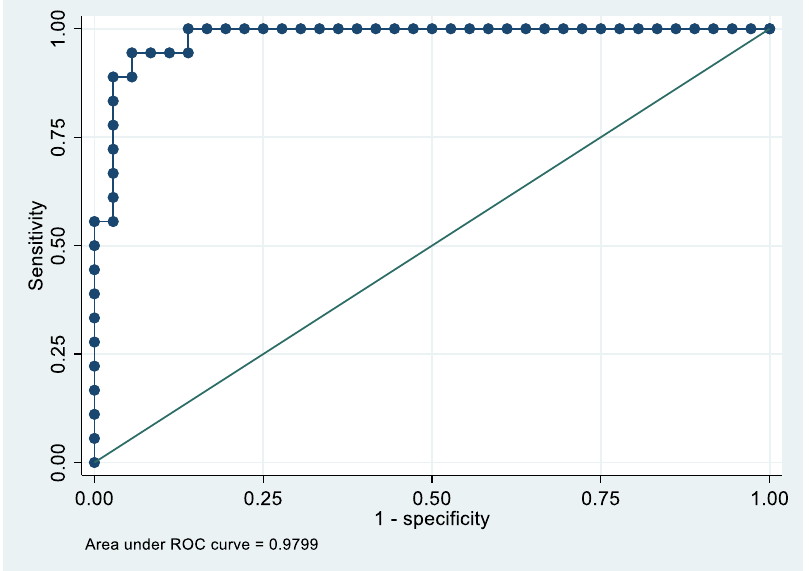
Figure 7. Receiver operating characteristics curve of the final model with the outcome Stage 1 EC patients vs. controls.